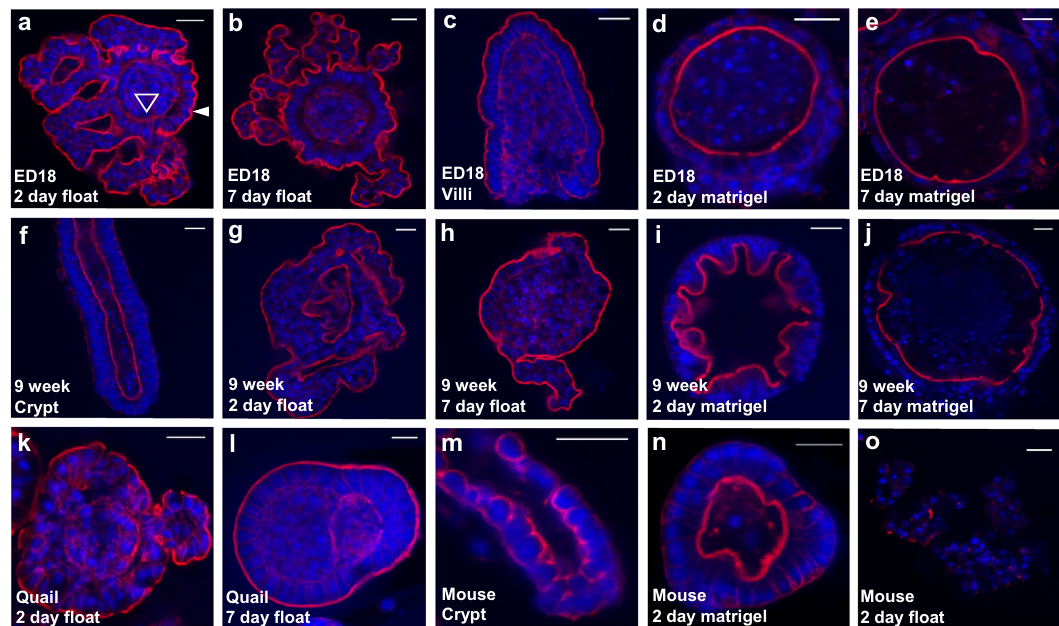
Fig. 2 Reverse polarisation of avian fl oating enteroids. Confocal images of whole-mount enteroids stained to detect F-actin-expressing brush borders (red) and DAPI to visualise cell nuclei (blue). a Floating embryonic chicken enteroids at 2 days of culture showing epithelial cells polarised with the apical brush border (closed arrow) facing the media and basal lamina (open arrow) sits on a central core of cells. b Embryonic chicken enteroids at 7 days of culture showing ‘ inside-out ’ polarisation. c Tissue isolated from embryonic chicken intestine to form enteroids are villi. d Embryonic enteroids cultured in Matrigel for 2 days with epithelial cells polarised so the apical brush border is facing a central lumen. e Embryonic enteroids cultured in Matrigel for 7 days. f Isolated crypts from 9 week old chicken intestine. g Enteroids from 9 week old chickens mimic embryonic chicken enteroid polarisation at 2 days and h 7 days in fl oating culture. i Matrigel-embedded enteroids from 9 week old chickens at 2 days and j 7 days. k Enteroids derived from 1 week old quail also show ‘ inside-out ’ polarisation at 2 days and l 7 days of culture. m Isolated crypts from adult mouse intestine. n Matrigel-embedded mouse enteroid with internal lumen at 2 days in culture. o Floating mouse enteroid at 2 days in culture showing dissociated crypt cells. Scale bar: 20 µ m. Images a – e , and f – o are representative of 3 cultures composed of 3 chicken embryos and 1 mouse per culture